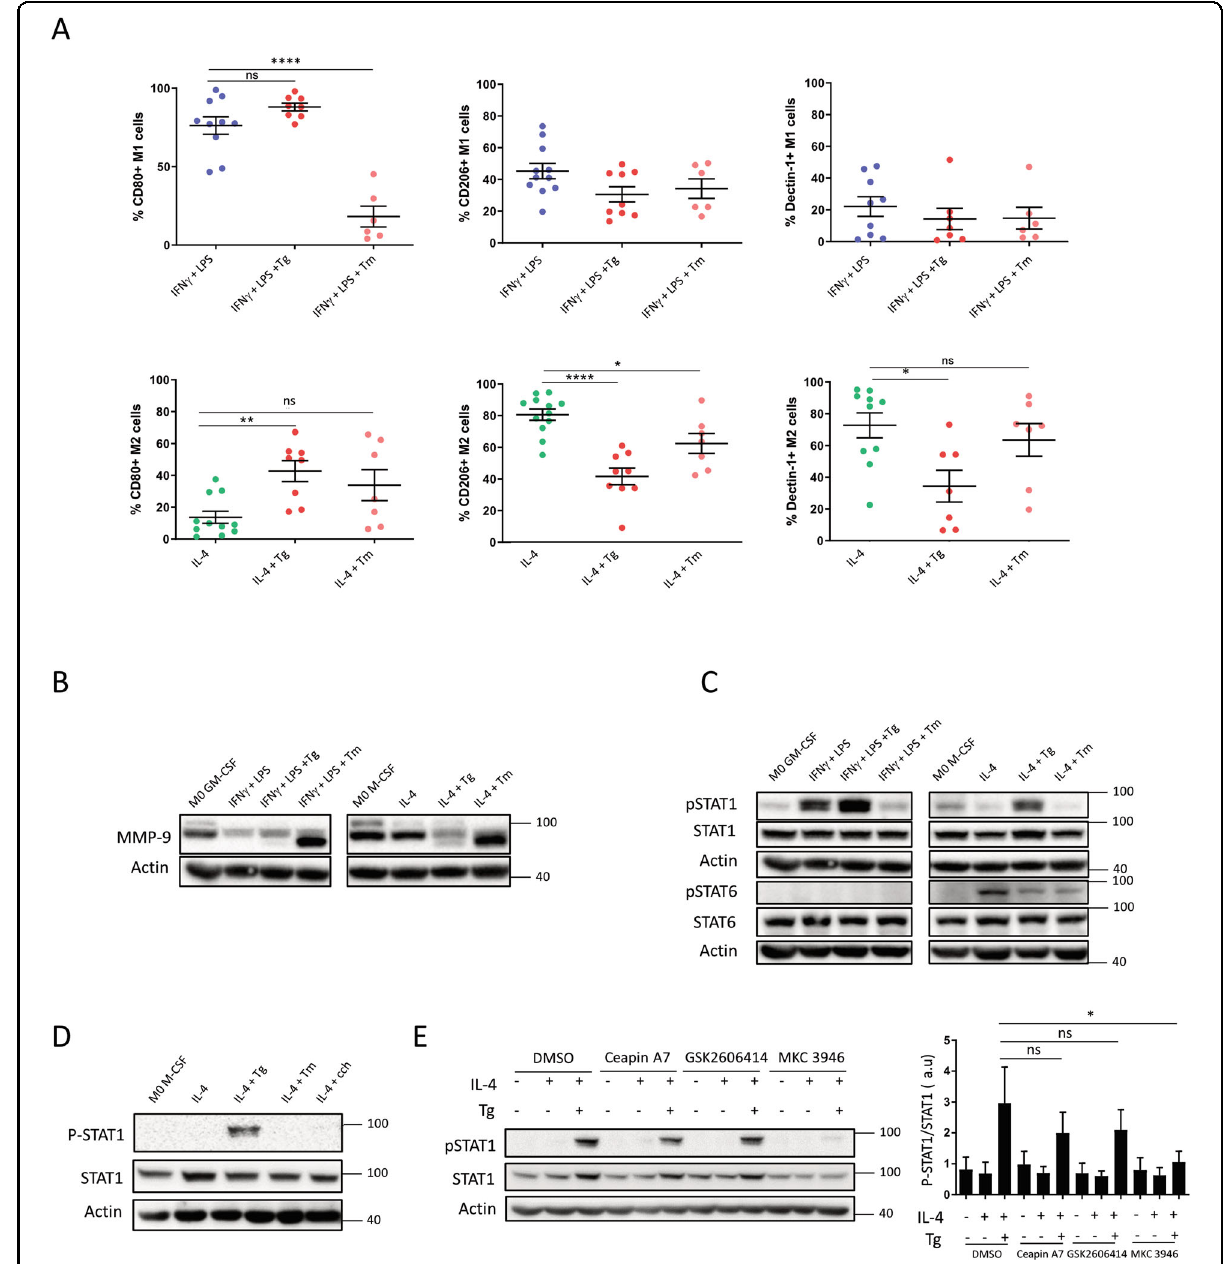
Fig. 2 Tg impacts M2(IL-4) phenotype via the UPR IRE1 α pathway. A Membrane expression by FACS analysis of CD80, CD206 and Dectin-1 on M1 and M2 macrophages treated or not with Tg or Tm ( n = 6 – 9). B Western-blot analysis of MMP-9 ( n = 3) in M1 and M2 macrophages treated or not with Tg or Tm during 24 h. C Western-blot analysis of signalization proteins pSTAT1/STAT1 and pSTAT6/STAT6 ( n = 5) in 24 h activated M1 and M2 macrophages treated or not with Tg or Tm. D pSTAT1/STAT1 signalization proteins in 24 h activated M2 macrophages treated or not with Tg, Tm or carbachol (cch, 1 μ M) ( n = 3). E Western-blot analysis of signalization proteins pSTAT1/STAT1 in 24 h activated M2 macrophages treated or not with Tg and with or without 5 μ M of ceapin A7, GSK2606414 and MKC 3946, inhibitors of the ATF6, PERK and IRE1 α UPR pathway respectively ( n = 4). * p < 0.05; ** p < 0.01; *** p < 0.005; **** p <